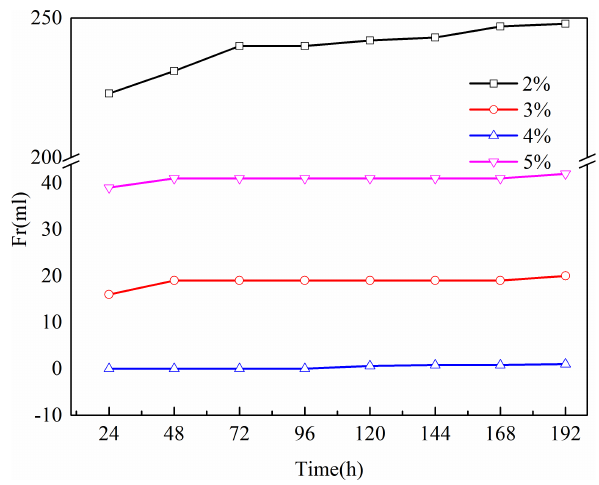
Figure 5: Foam stability